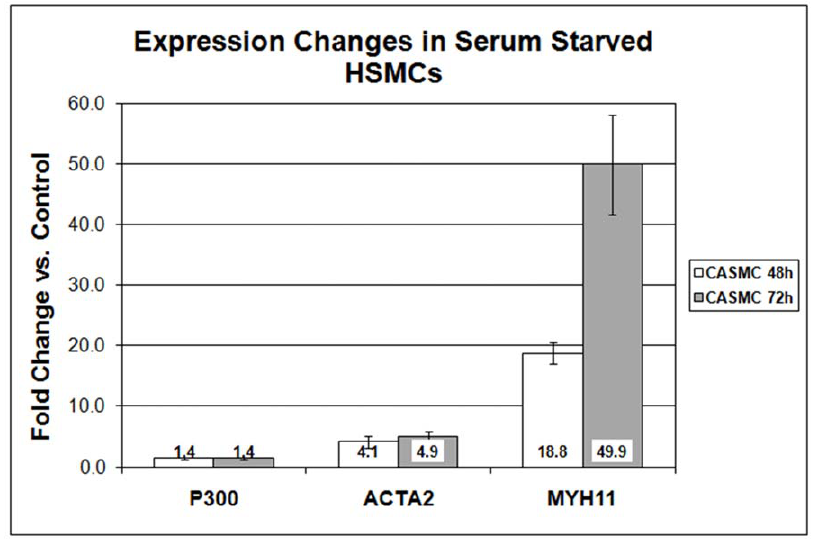
Figure 6. Gene regulation in human coronary SMCs by qRT-PCR. Cells were serum starved in basal medium for up to 72 h to induce differentiation. P300 = EP300 HAT, ACTA2 = SM a -actin, MYH11 = SM-MHC. 48 and 72 h time points are shown as fold change from baseline 6 standard error. All values are significantly increased vs. control (p , 0.05).